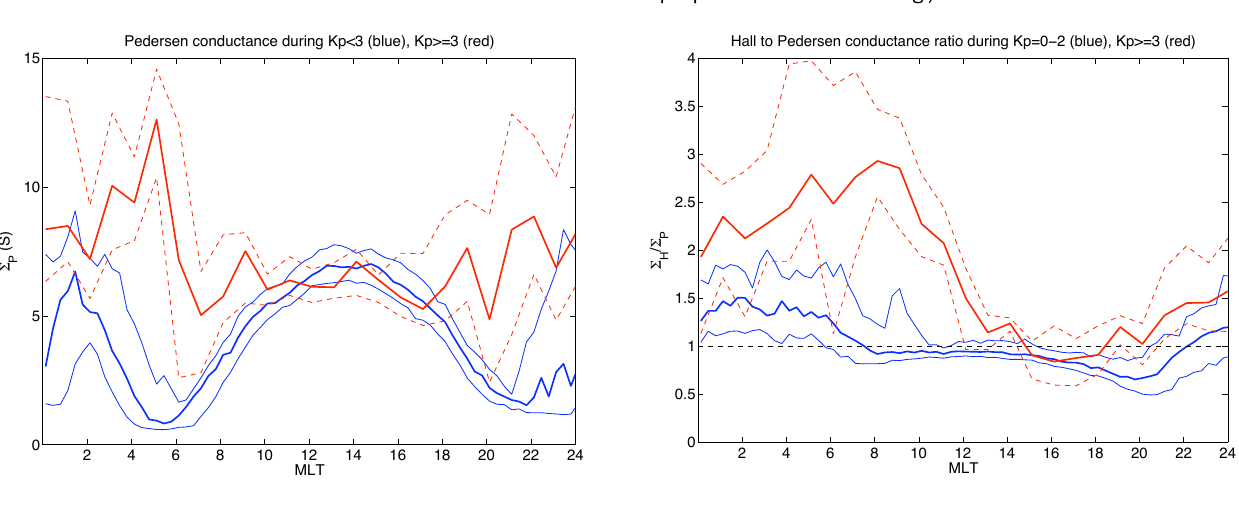
Fig. 6. Hall to Pedersen conductance in the same format as Fig. 4. The low activity median of Hall to Pedersen conductance ratio is close to 1.0 during midday but becomes less than